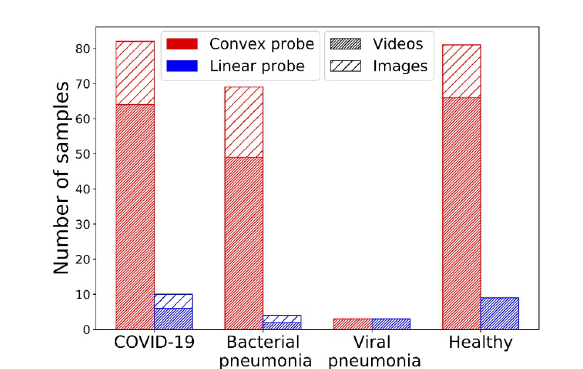
Fig. 3. Graphical representation of LUS dataset consisting of various lung ultrasound data of healthy and affected lungs.